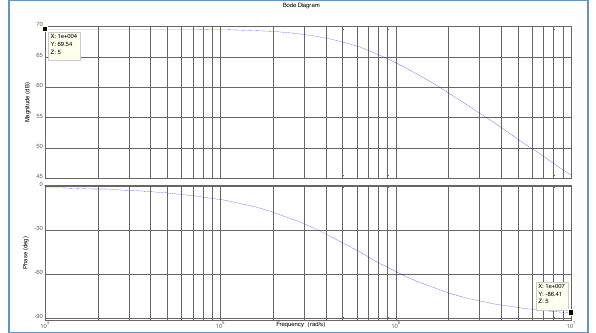
Figure 9. bode diagram of the transfer function of detector circuit based on the transimpedance amplifier circuit.